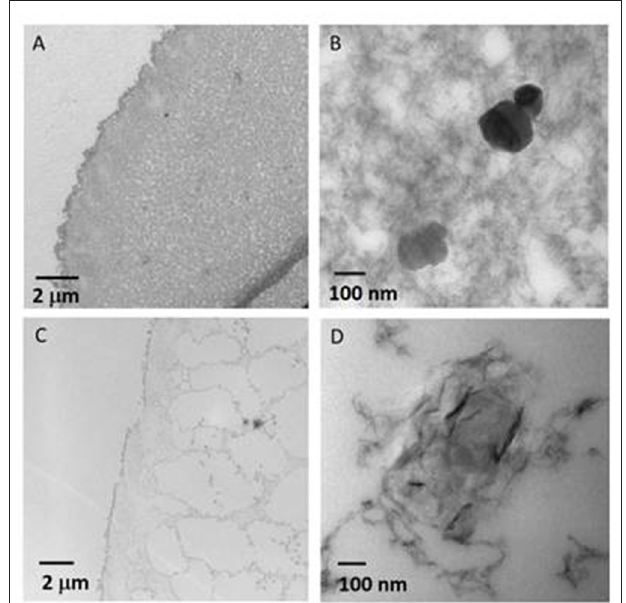
M O ) were observed on the spectra below − −